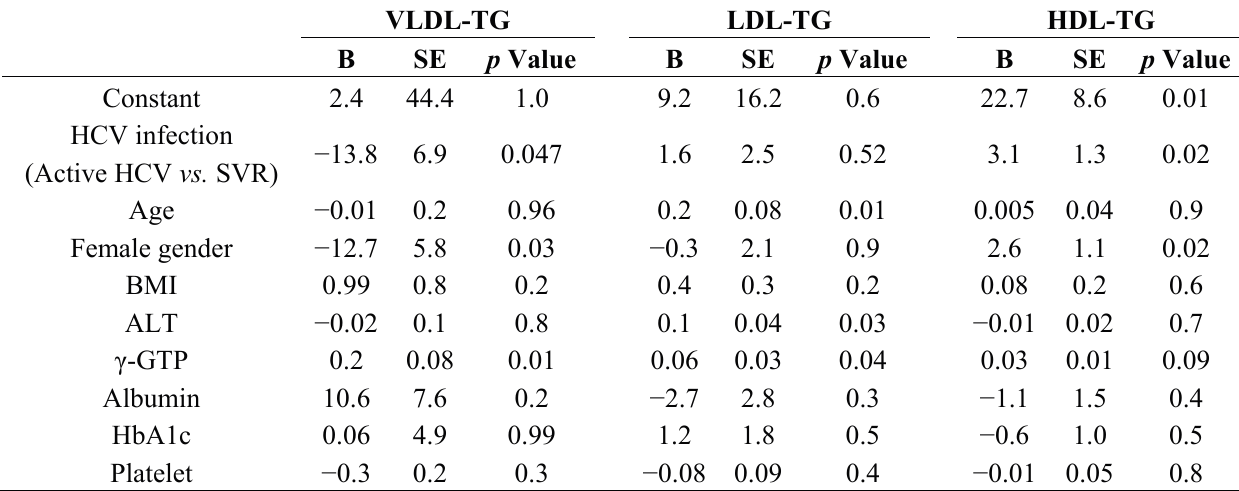
Figure 2. Comparison of TG concentrations in the four major classes of serum lipoproteins between active HCV and SVR groups. (** p < 0.01; *** p < 0.001). Table 2. Significance of chronic active HCV infection on serum levels of lipoproteins analyzed by multiple regression